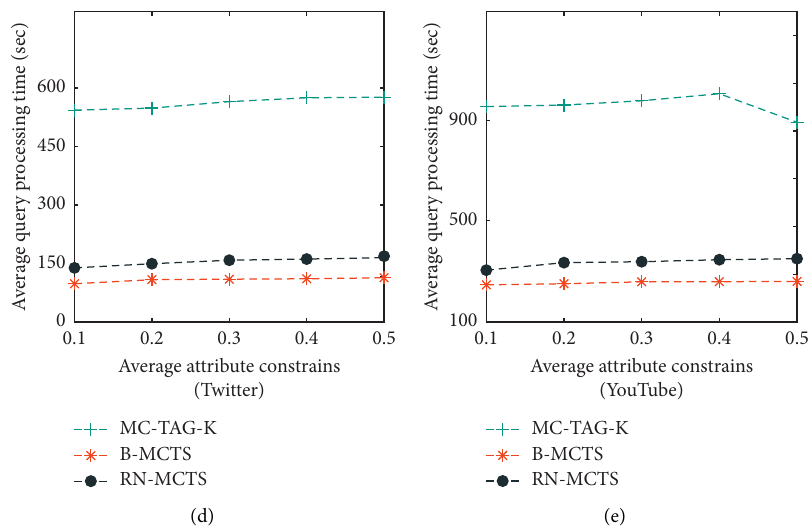
Figure 4: The average query processing time based on different